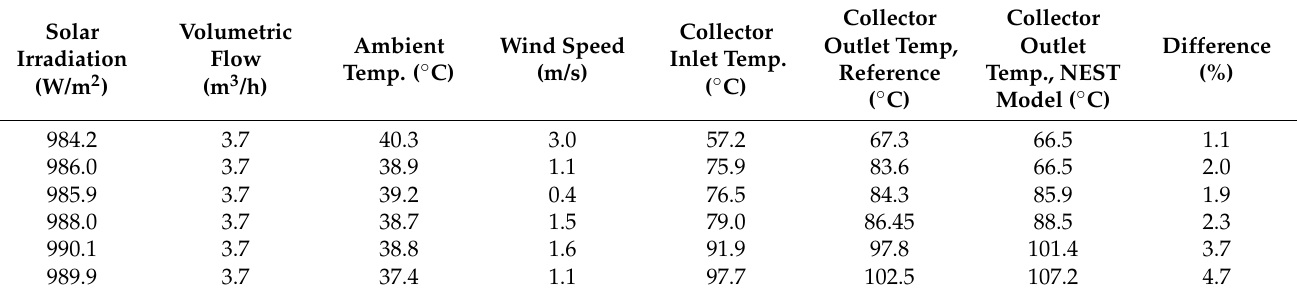
Table 2. Characteristics of the PTC-1800